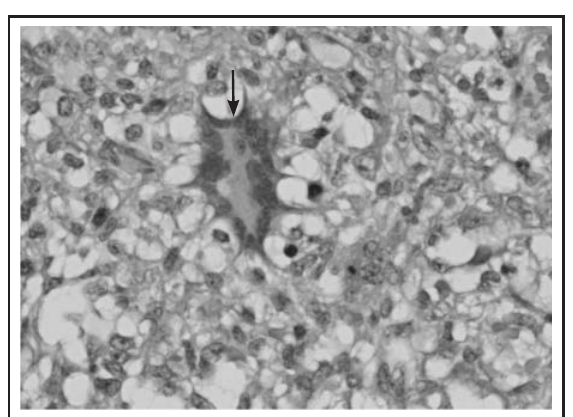
Figure 4. Section showing a multinucleated giant cell